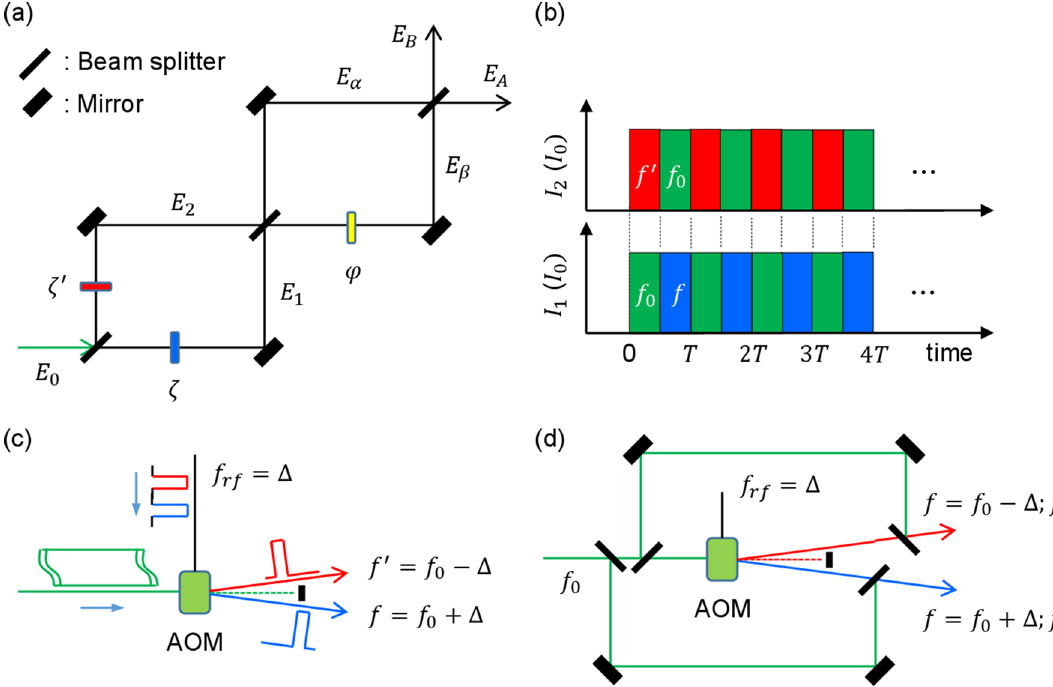
Figure 1. Schematic of macroscopic entangled field generation. ( a ) A Mach–Zehnder interferometer for Hong- Ou-Mandel type proof. ( b ) Alternative pulse sequence. ( c ) Symmetric detuning. ( d ) Superposition for basis